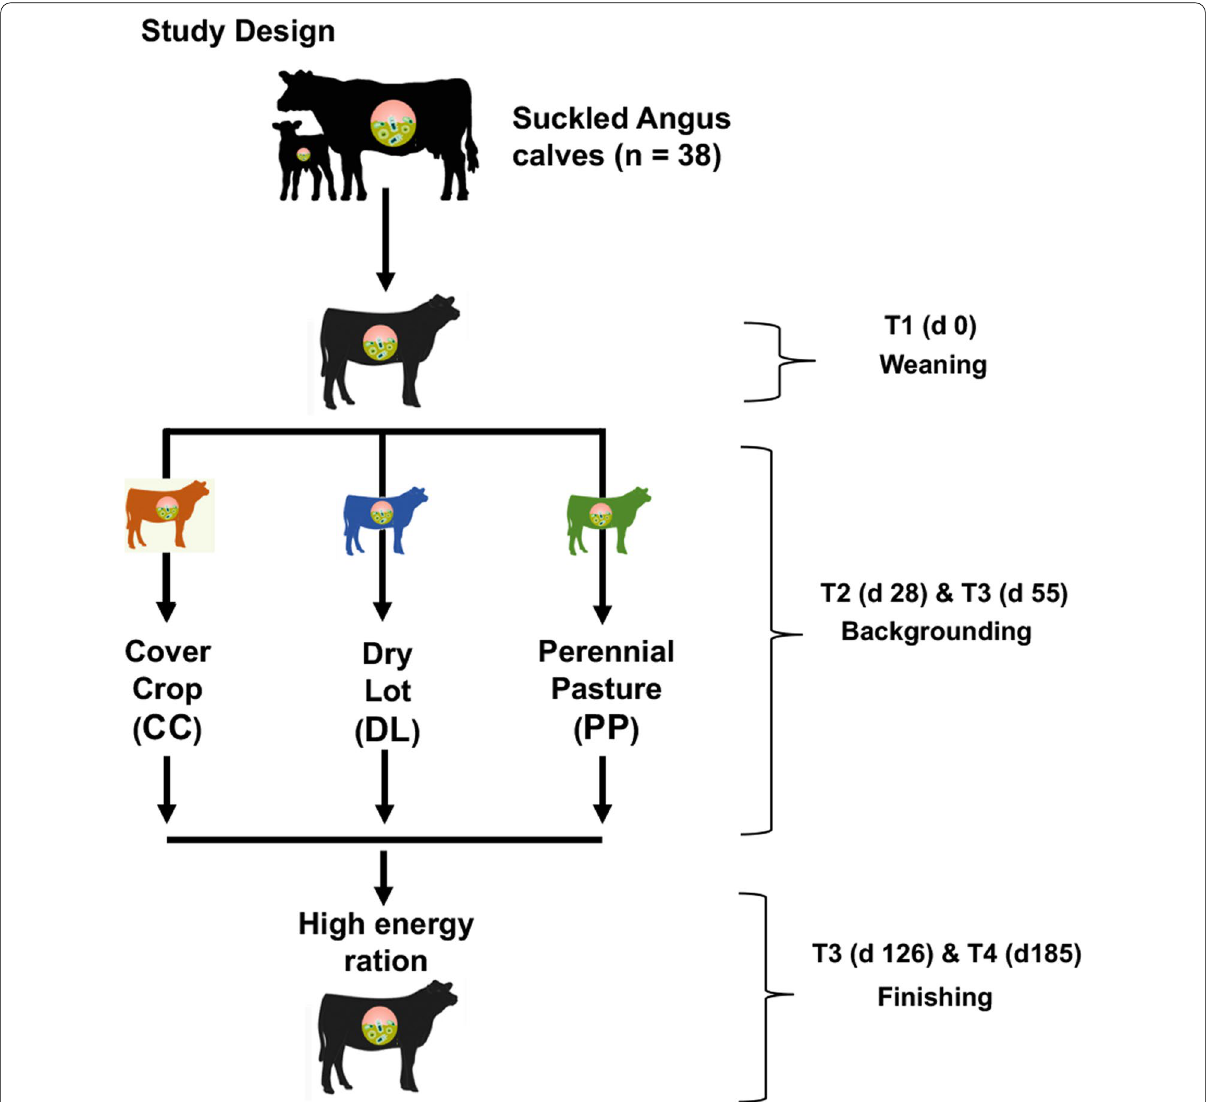
Fig. 1 Rumen fluid sampling protocol for 38 Angus and Angus x Simmental beef calves across five points during backgrounding (BKG) and finishing. After weaning, the calves were randomly allocated to three different BKG systems: (i) dry lot (DL, n (iii) a third group remained grazing on perennial pasture (PP, n twice during BKG (T2–T3), and twice at finishing (T4–T5), when calves were kept on a high energy feedlot diet (FLD). Details on the nutritional composition of BKG and FLD diets can be seen in Table